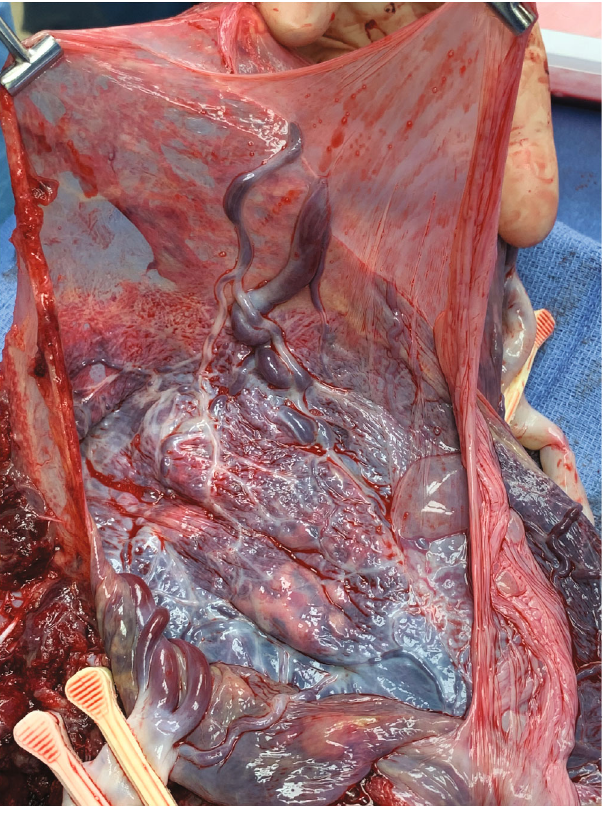
Figure 6: Gross image of the specimen showing vessels passing through the amnion as well as the unprotected insertion of umbilical